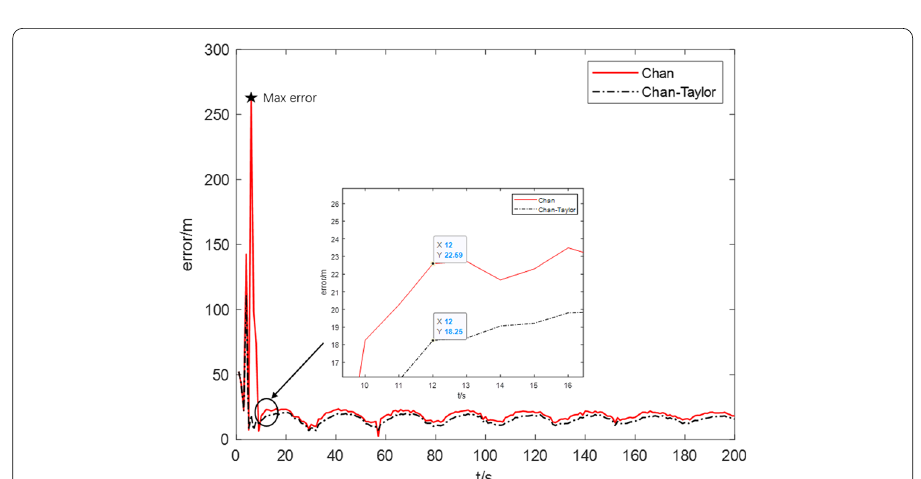
Fig. 18 Positioning error of the Chan and Chan–Taylor hybrid